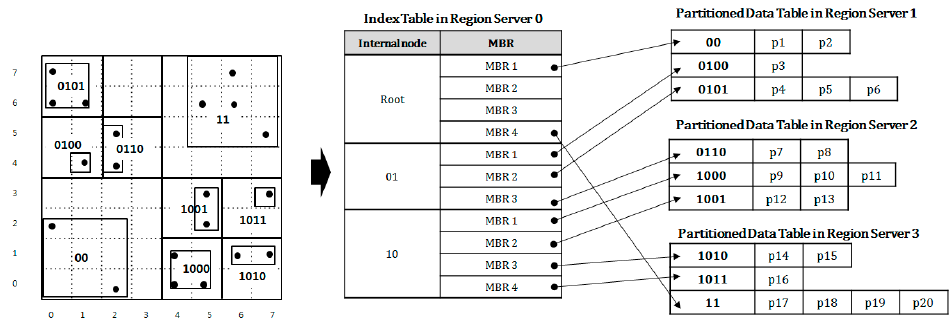
Figure 6. QbMBR tree index implementation on HBase.